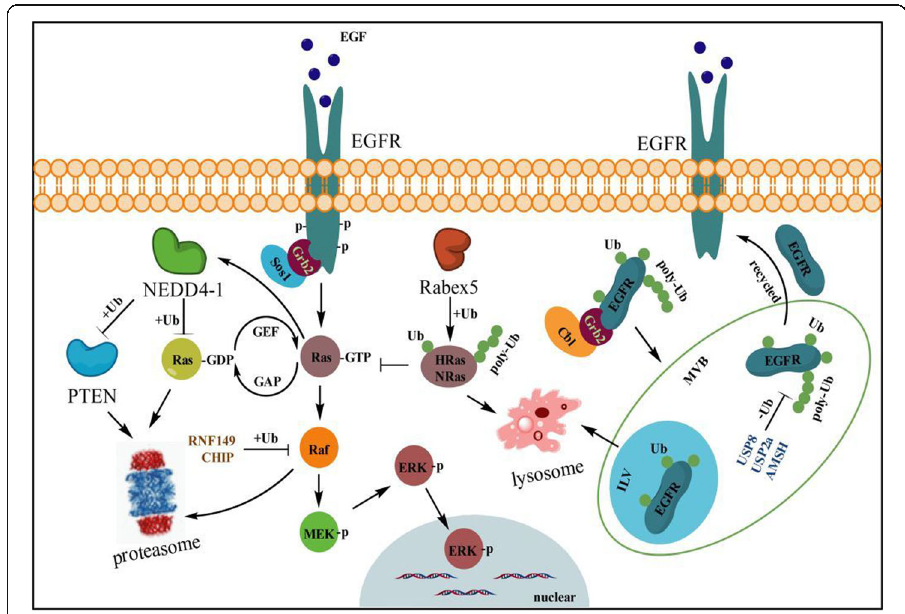
Fig. 1 Ubiquitination on RAS-RAF-MEK signal. Upon EGF or other growth factors stimulation, activated Ras- GTP enhances the transcripts of NEDD4 – 1 which promotes the ubiquitination on all three forms of Ras-GTP and PTEN for the proteasome degradation to accelerate the downstream signaling activation. Rabex, to some extent as a ‘ break ’ , can ligate mono- or poly-ubiquitin (K63-link) to HRas or NRas, but not KRas, which promotes their endosome localization and lysosome degradation, thereby limiting the transformation of Ras-GTP from Ras-GDP to suppress the phosphorylation activation of ERK. Likewise, BRAF and CRAF can be ubiquitinated by RNF149 and CHIP, respectively, and be degraded by the proteasome to decelerate MEK/ ERK activation, which attenuates the increase in cell growth. Following EGF stimulation, RING domain E3 ubiquitin ligases c-Cbl or Cbl-b, with the assistance of Grb2, induces mono- or poly-ubiquitination (K63-link) of EGFR and mediates the endosomal sorting and trafficking events, in which process the mono- ubiquitinated EGFR is trapped within ILVs of multivesicular bodies (MVBs), whereas poly-ubiquitinated forms remaining in the MVBs are deubiquitinated by DUB enzymes USP8, USP2a or AMSH to escape the ILVs trapping and lysosome degradation. Instead, the non-ubiquitinated EGFR forms are recycled to the